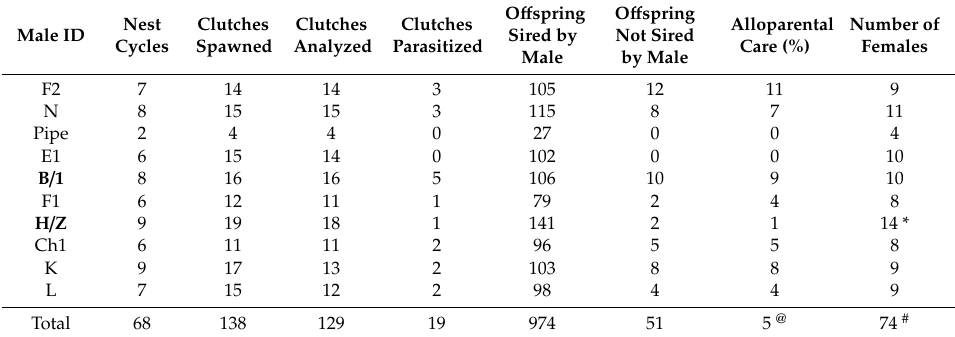
Table 3. Summary of spawning activity and parentage data. Spawning activity for each male includes the number of nest cycles and number of clutches spawned in these nests. Except for two males that used two nesting sites (bold), one guardian male was associated with each nest site. Clutches analyzed includes those for which genetic data were successfully collected. The number of clutches where reproductive parasites were detected includes only those clutches where alleles in at least one o ff spring did not match paternal alleles at two or more loci. The total number of o ff spring assigned to each guardian male is compared to the number of o ff spring with genotypes incompatible with the guardian male. The resulting percentage of unrelated o ff spring cared for by the guardian male and the number of females identified spawning with each male is